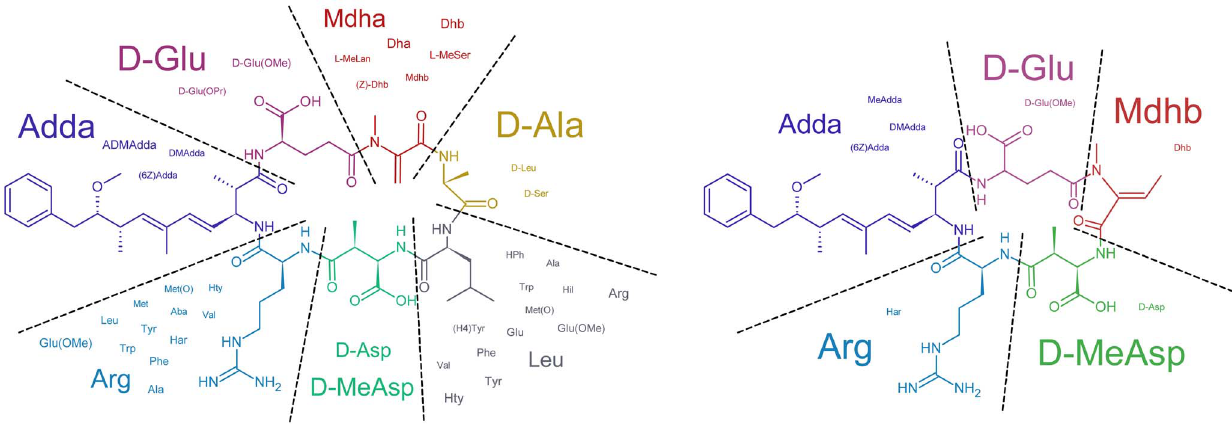
Figure 1. General structures of microcystins and nodularins. Prevalence of residues found within microcystins (left) and nodularins (right) is proportional to the font size of the respective residue. Data used to generate this figure is deposited at http://dx.doi.org/10.6084/m9.figshare.880756.